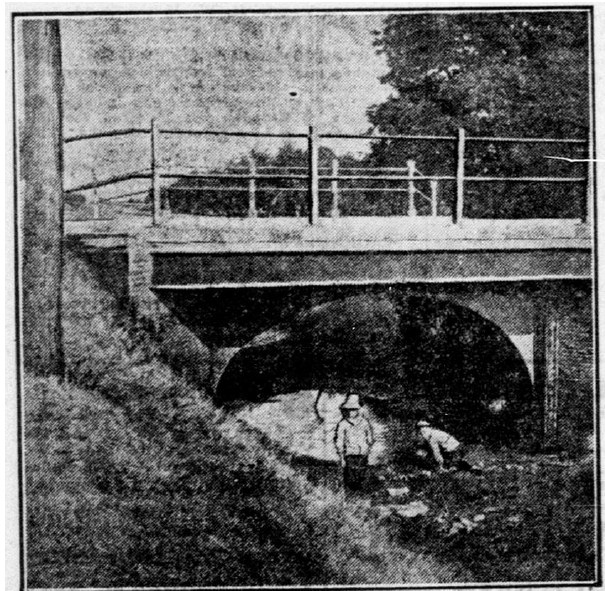
Figure A4. Photograph from the Dutch newspaper De Telegraaf , 20 July 1921. The original caption is “The drought. The river Linge holds since some time, as many of our rivers in our country, no water anymore. Only under the bridges is some water left and kids fill a jug to relieve the water shortage at home.”